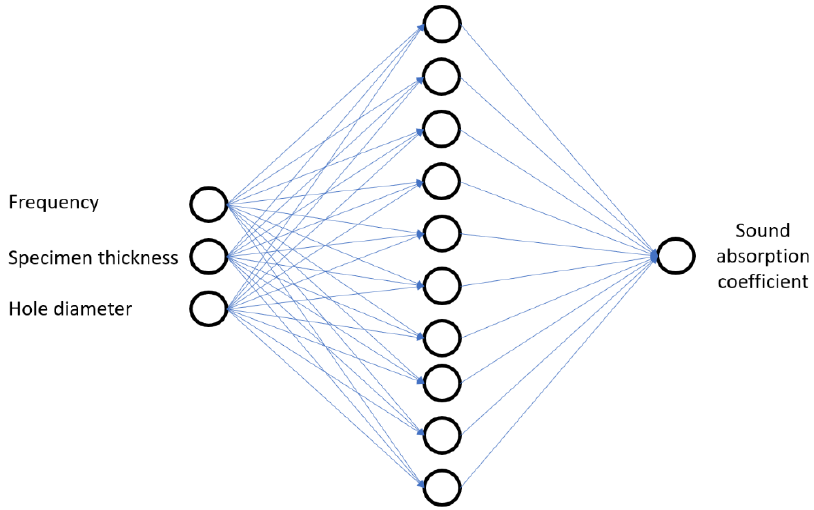
Figure 6. Architecture of the algorithm based on artificial neural networks used to simulate the acoustic behavior of a ceramic resonator. In the input layer, there are three inputs: Frequency, specimen thickness, and hole diameter. In the hidden layer, there are ten nodes. Finally, in the output layer, there is a single output, that is, the sound adsorption coefficient.